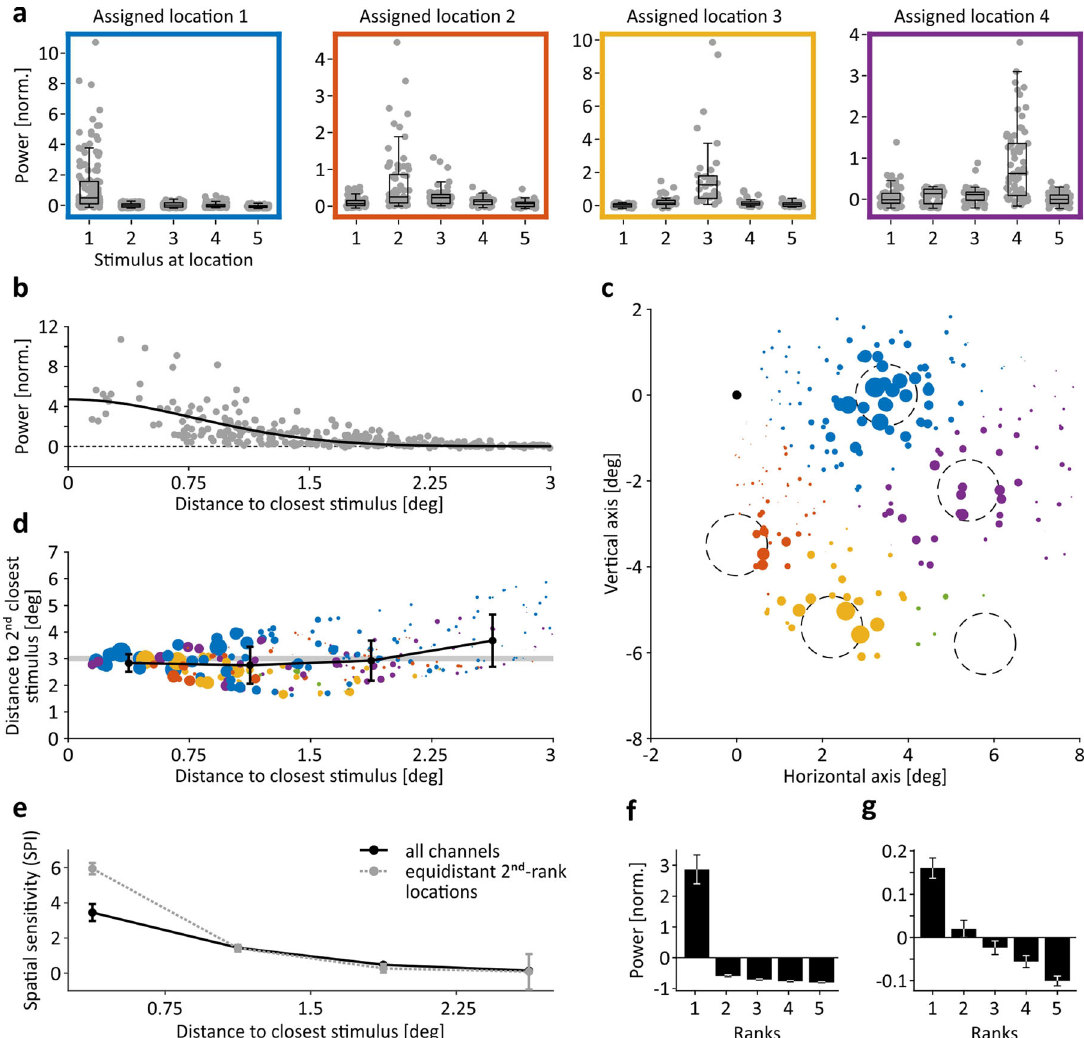
Fig. 3 EFP modulation as function of stimulus location. a Trial-averaged gamma power ( y -axes) of individual channels (gray dots) with ERFs close to stimulus location 1 – 4 (left to right) in response to stimuli shown at locations 1 – 5 ( x -axes). Boxplot on top of individual channel data indicates median, 25th, and 75th percentile. Whiskers indicate interquartile range. b Mean gamma-band responses as function of distance between closest (assigned) stimulus location and ERF activation peak. Black line represents half-Gaussian fi t to data. c Spatial sensitivity map in visual fi eld coordinates. Colored dots represent individual EFP-channels, dot X – Y coordinates indicate center coordinates of the respective ERF, dot color represents assigned stimulus location, dot size is scaled by spatial sensitivity SPI . Dashed circles indicate size and position of large stimuli, black dot indicates fi xation point. d Spatial sensitivity SPI as function of distance to closest and 2nd-closest stimulus. Conventions for size and color of dots as in ( c ). Black line shows mean distance of 2nd-closest stimulus, error bars indicate SD, gray-shaded area indicates distance to 2nd-closest stimulus at 3 ± 0.1-degree (equidistant 2nd-rank locations in ( e )). e Mean spatial sensitivity as function of distance between ERF center and center of closest (assigned) stimulus, as individually shown in ( b – d ). Straight black line, all channels; dashed gray line, channels with distance of 3 ± 0.1-degree to 2nd-closest stimulus. f – g Mean normalized gamma power of channels with ERF-stimulus distance below 0.75-degree ( f ) and between 2.25- and 3-degree ( g ) in response to the closest stimulus ( y -axis, rank 1) and to stimuli at increasing distances (ranks 2 – 5), as obtained by a corresponding re-sorting of the data shown in ( a ). Error bars indicate